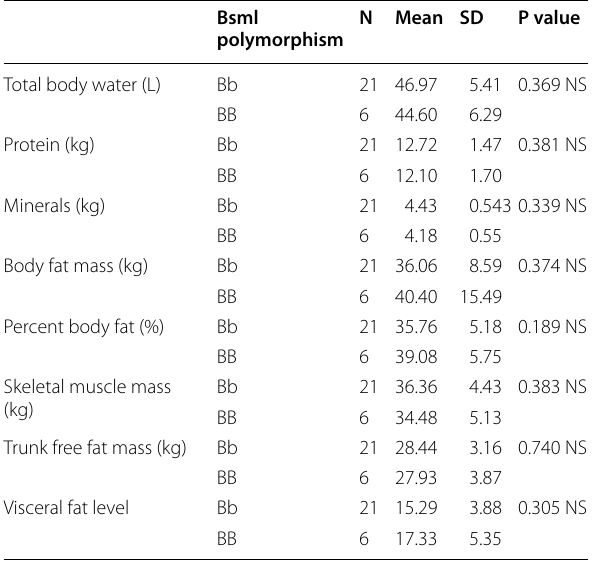
Table 3 Bsml Polymorphism in relation to InBody bioelectrical impedance among obese male medical